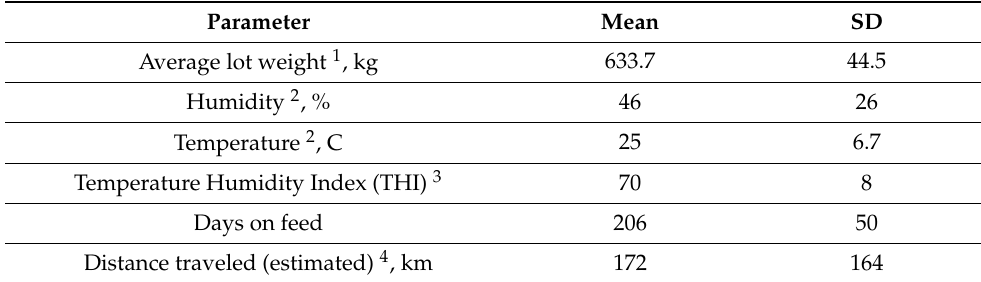
Table 2. Description of lot level characteristics measured as potential risk factors associated with fed cattle mobility ( N = 158 lots representing 15,388 head of